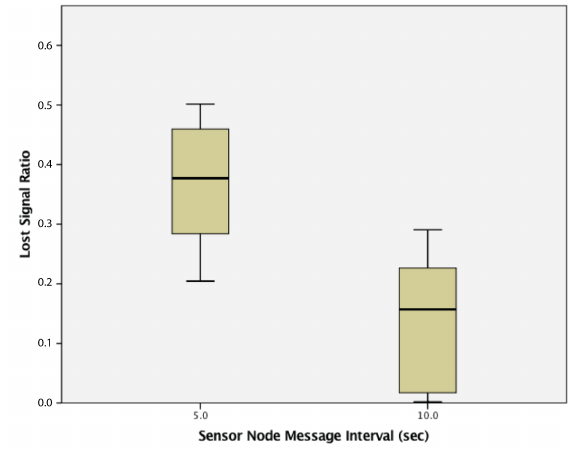
Figure 16. Lost signal ratio of clusters of passive wireless sensor nodes with 5 s vs. 10 s transmission intervals.